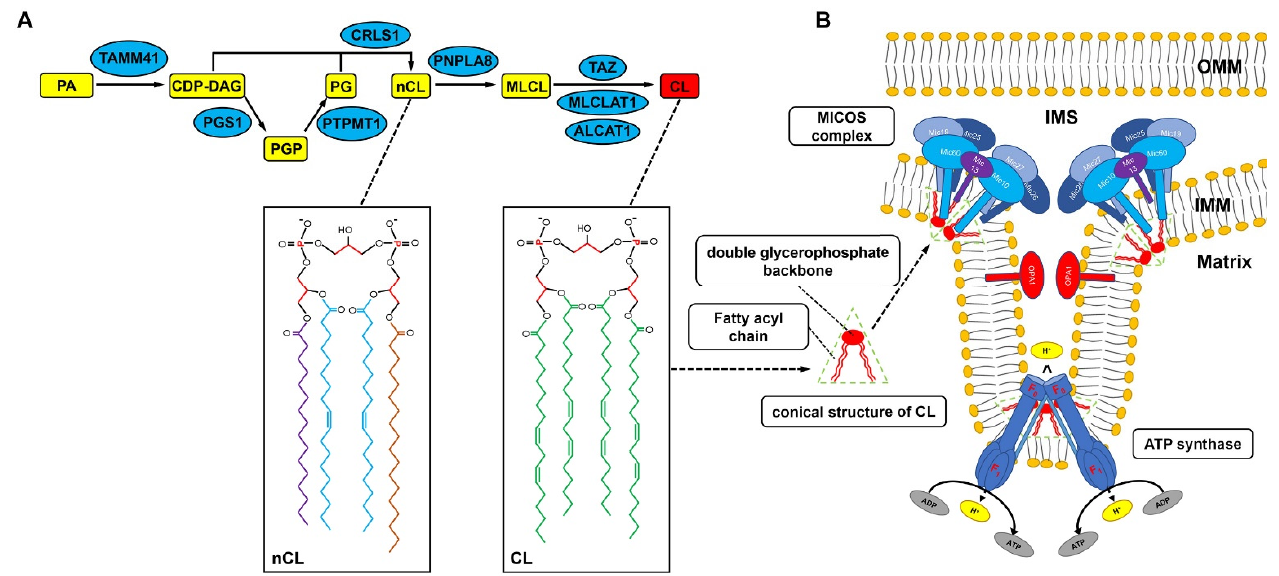
Figure 1. Schematic diagram depicting the synthesis, remodeling, and localization of CL inside the mitochondria. ( A ) Inside the mitochondria of mammalian cells, the biosynthesis of CL begins with the conversion of phosphatidic acid (PA) to CDP-DAG catalyzed by TAMM41, followed by the transfer of a phosphatidyl group from CDP-DAG to glycerol-3-phosphate to form PGP, a process catalyzed by PGS1. PGP is subsequently dephosphorylated by PTPMT1 to generate PG, and CL is synthesized by CRLS1 through an irreversible condensation reaction of PG and CDP-DAG. The newly synthesized CL (nCL) contains a mixture of fatty acyl chains differing in length and saturation. To become mature CL, nCL undergoes a series of deacylations and reacylations, a process called remodeling. nCL is first deacylated to monolysocardiolipin (MLCL) by phospholipase A2 PNPLA8 and then reacylated by acyltransferases, including tafazzin (TAZ), acyl-CoA: lysocardiolipin acyltransferase 1 (ALCAT1), and MLCL acyltransferase-1 (MLCL AT1) to achieve a final symmetric acyl composition in mature CL. ( B ) The tetra-acyl chains and the negatively charged polar moiety give CL a conical shape, which results in CL causing negative curvature in the mitochondrial membrane and the IMM bending, forming the cristae. In addition, the mitochondrial contact site and cristae-organizing system (MICOS) complex and ATP synthase are also essential for the formation of mitochondrial